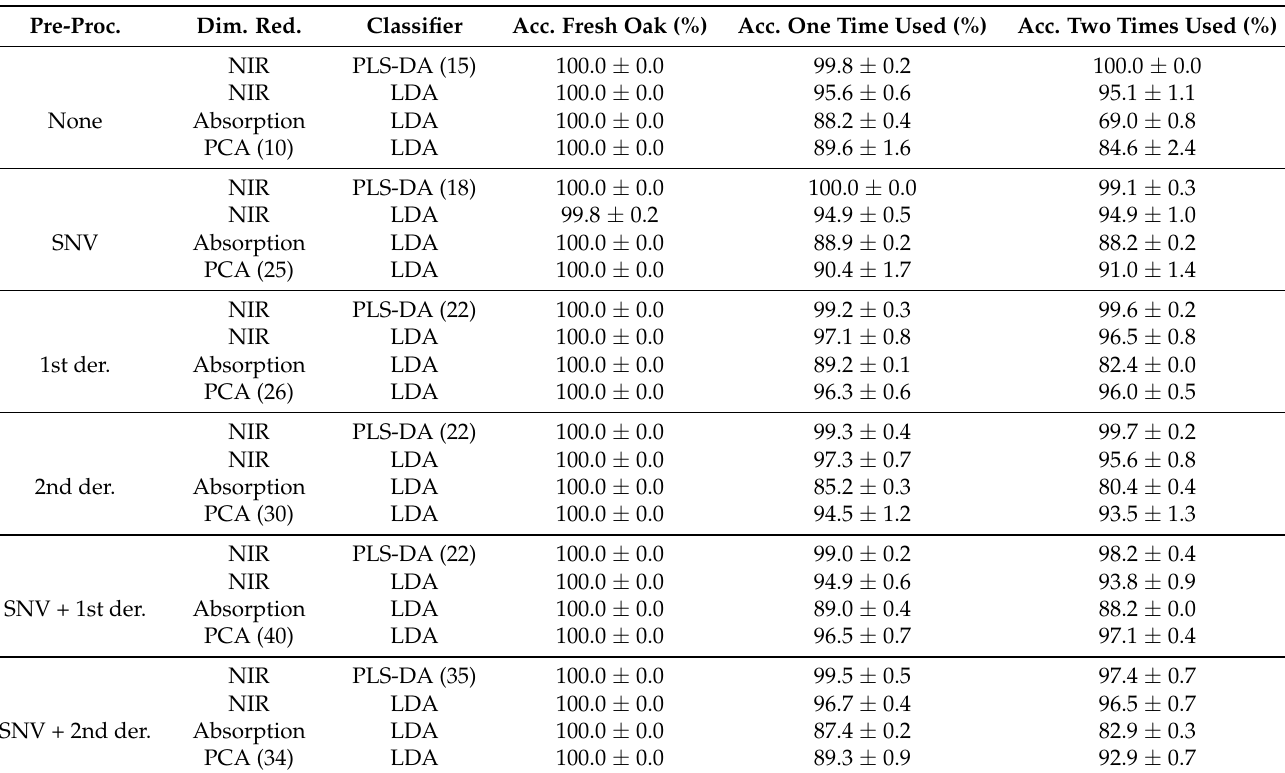
Table 1. Classification results based on reflectance spectroscopy. The optimal number of PLS or PCA components is denoted in brackets. The validation accuracy is given in the table, obtained by using repeated (nested) 5-fold cross-validation. The error is the standard error of the mean obtained by the 10 different